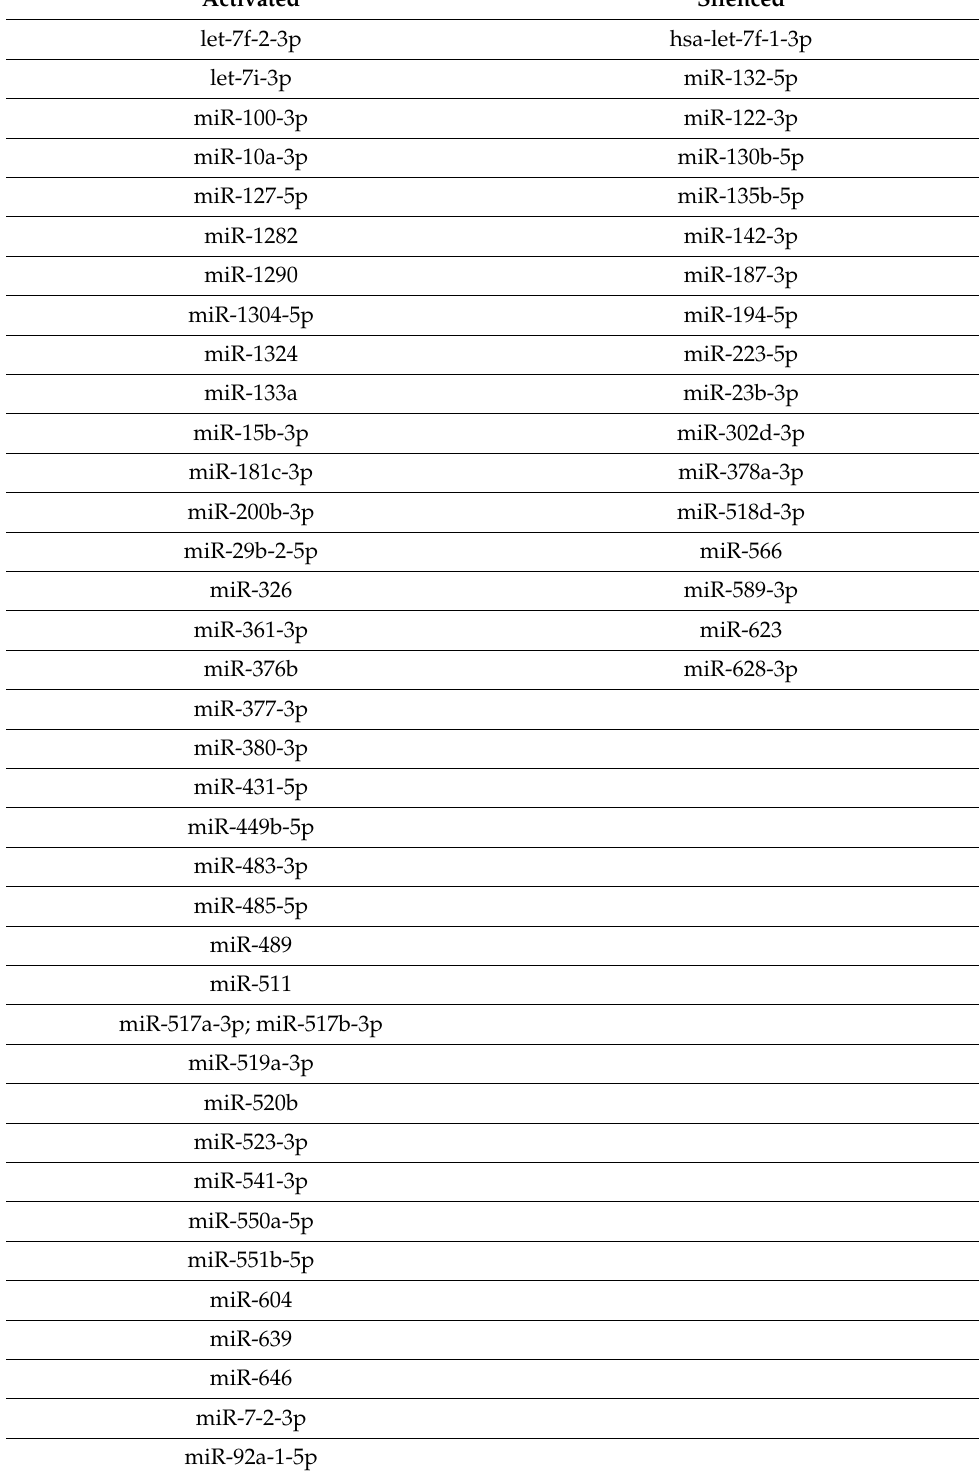
Table 2. Activated or silenced miRNAs by the IL-1 β